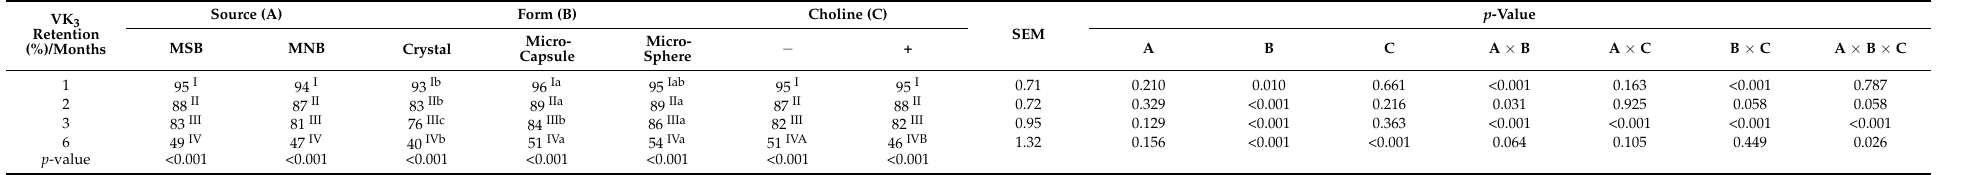
Table 4. Effects of sources and forms of vitamin K 3 and choline on the retention of vitamin K 3 in vitamin trace mineral (VTM)